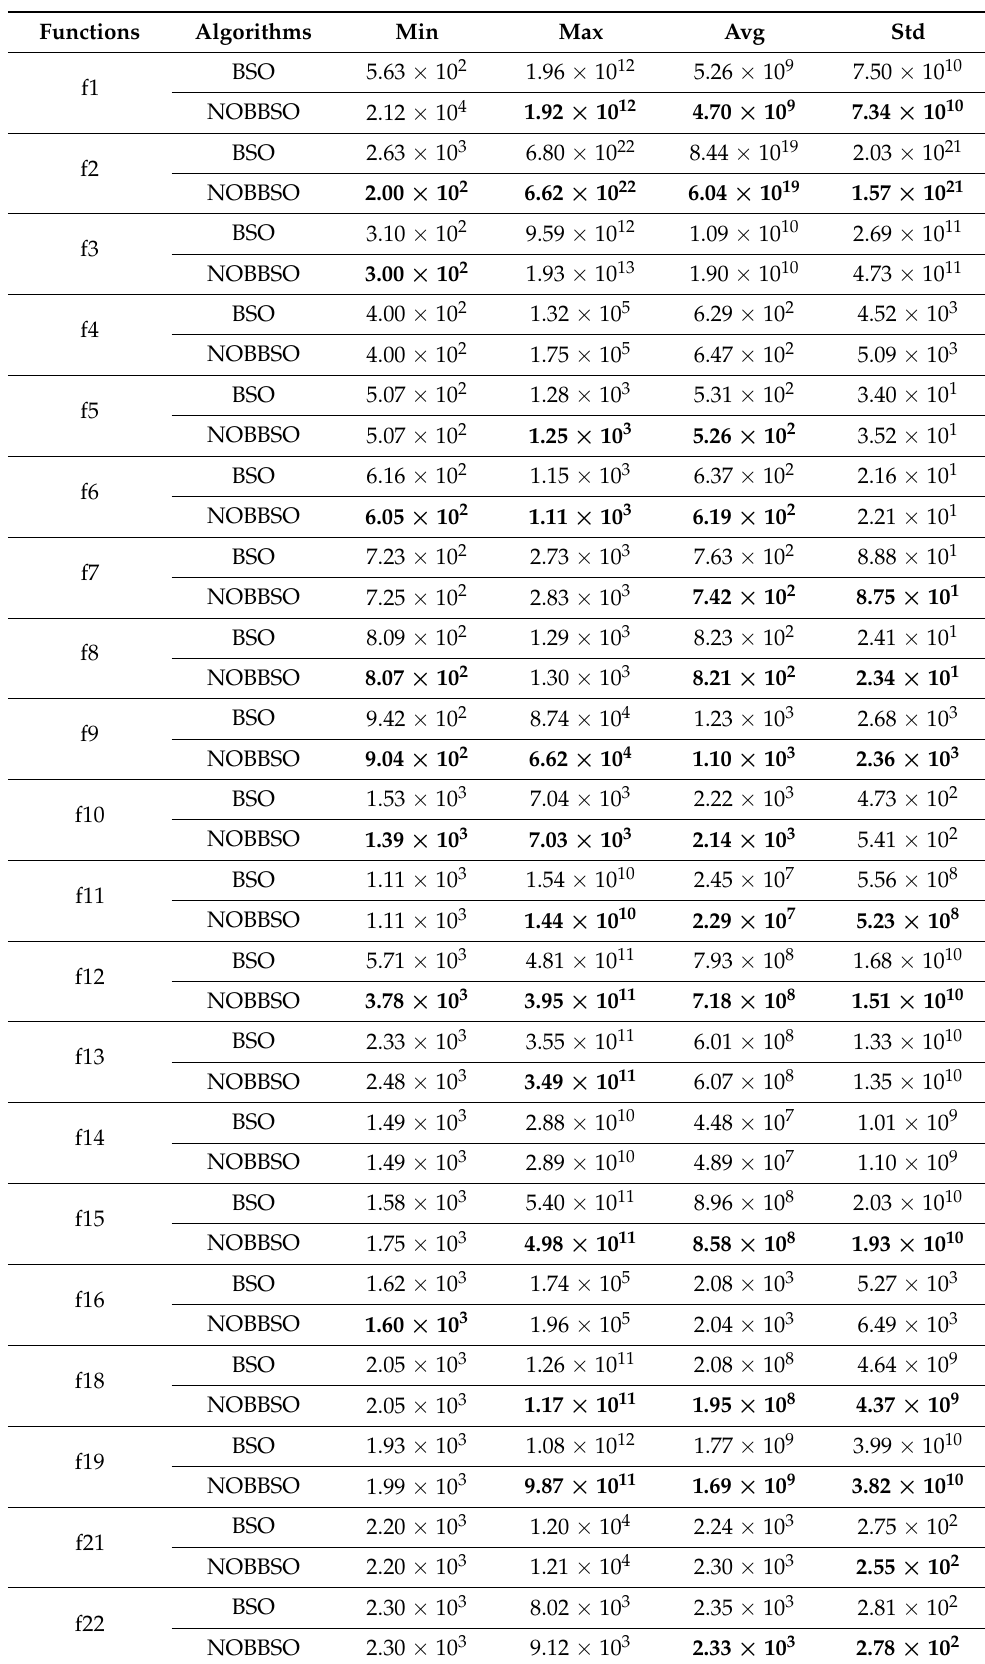
Table 5. Accurate results of two algorithms when D is